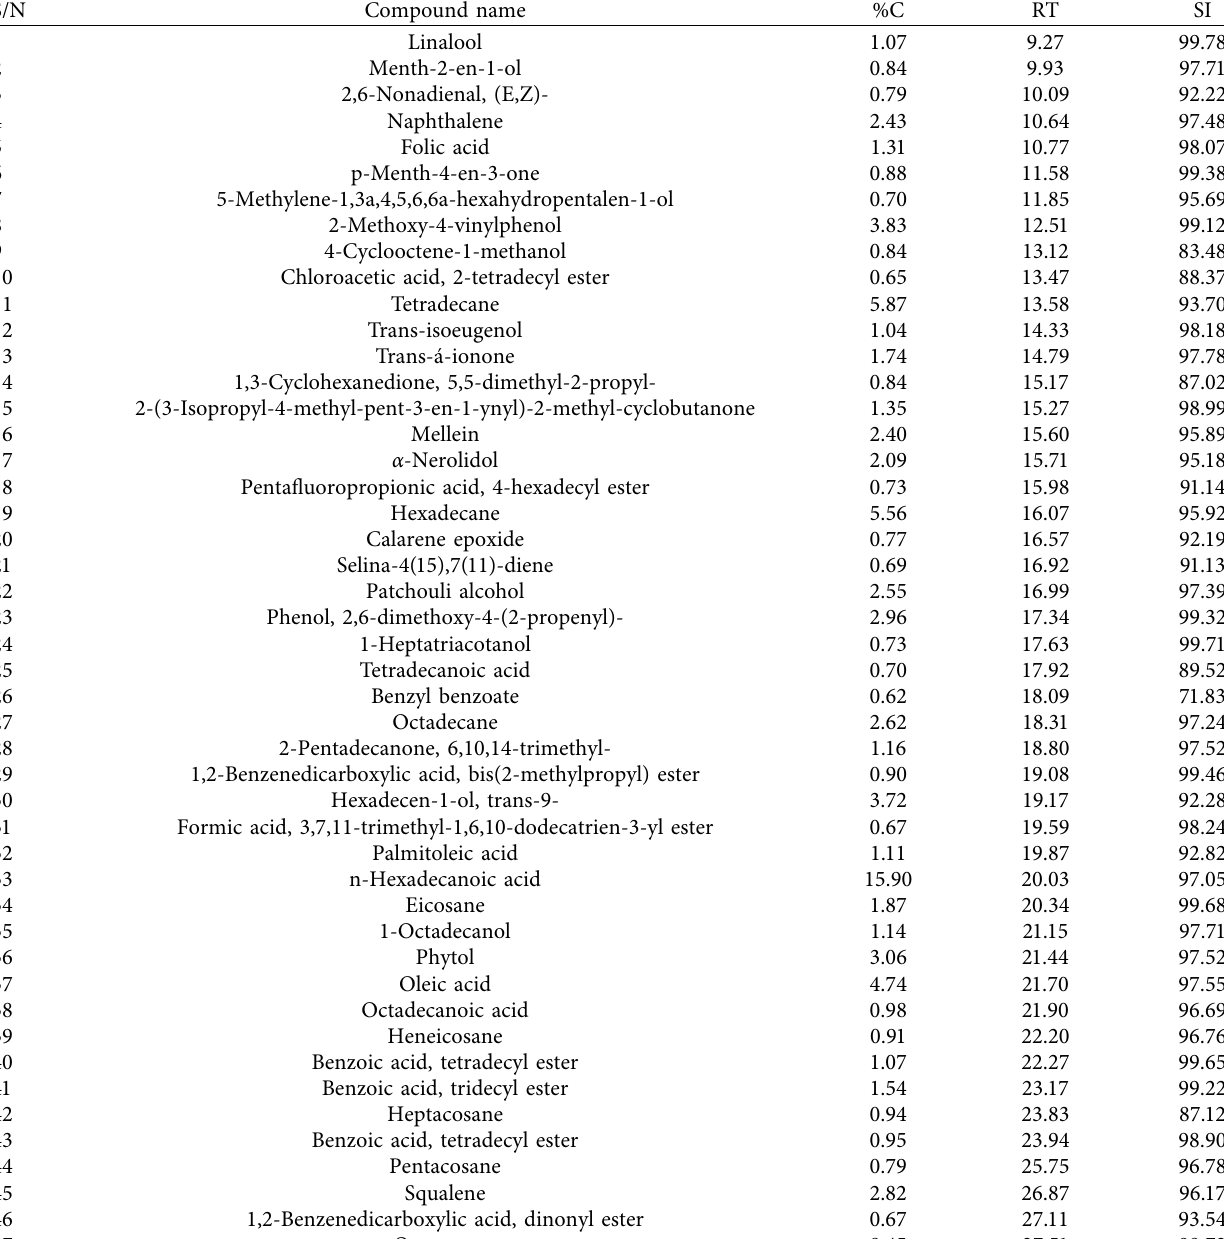
Table 2: Chemical composition of the essential oil obtained from the leaves of Vitex doniana